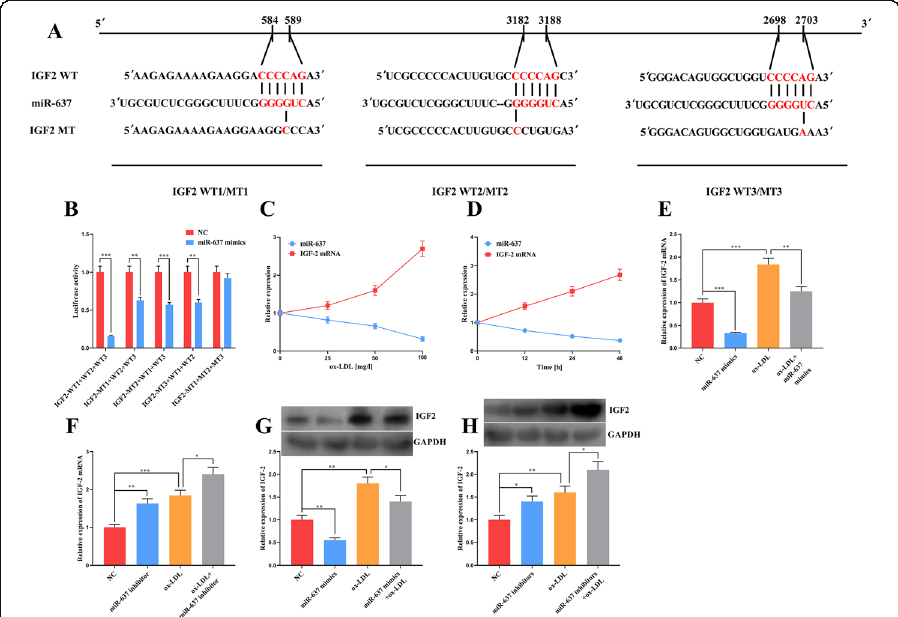
Fig. 3 The interaction between miR-637 and IGF-2. a – TargetScan database prediction of the binding sites between IGF-2 and miR-637. b – The targeted relationship between miR-637 and IGF-2 was verified using a dual luciferase reporter gene assay. c and d – The expressions of miR-637 and IGF-2 mRNA showed different trends depending on the ox-LDL concentrations and treatment time. e – The expression of IGF-2 mRNA was determined using real-time PCR after treatment with miR-637 mimics, 100 mg/l ox-LDL or miR- 637 mimics+ 100 mg/l ox-LDL. f – The expression of IGF-2 mRNA was determined using real-time PCR after treatment with miR-637 inhibitors, 100 mg/l ox-LDL or miR-637 inhibitors+100 mg/l ox-LDL. g – The expression of IGF-2 was determined using western blotting after treatment with miR-637 mimics, 100 mg/l ox-LDL or miR-637 mimics+ 100 mg/l ox-LDL. h – The expression level of IGF-2 was determined using western blotting after treatment with miR-637 inhibitors, 100 mg/l ox-LDL or miR-637 inhibitors+ 100 mg/l ox-LDL. *, ** and *** respectively indicate p < 0.05, p < 0.01 and p <